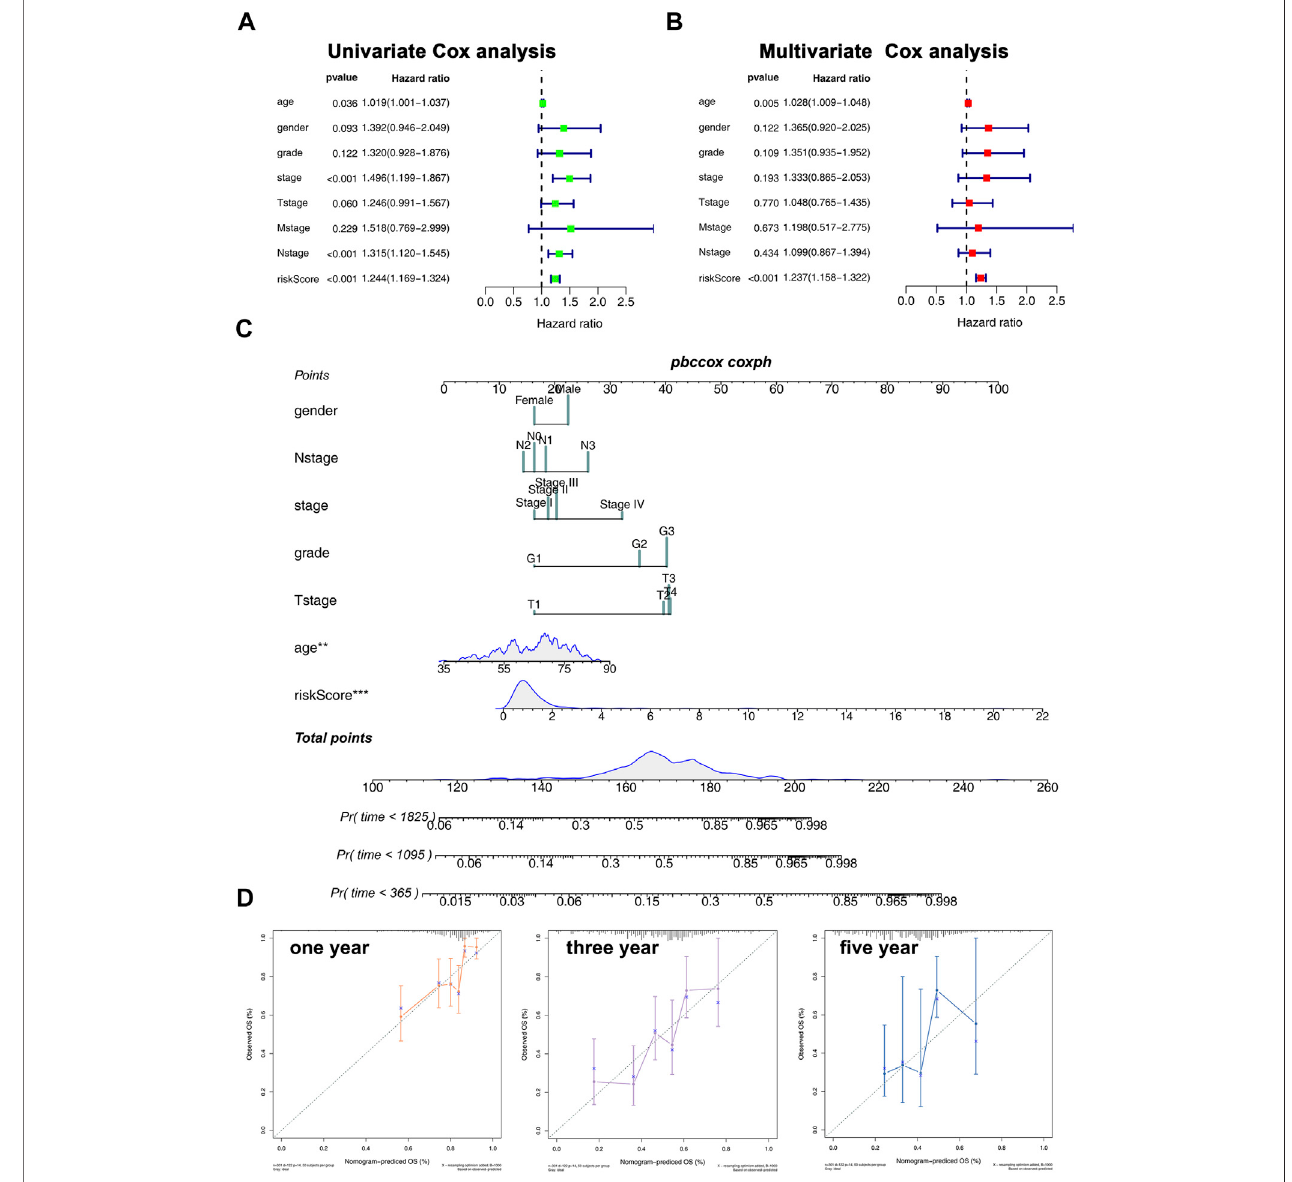
FIGURE 5 | Nomogram and calibration plots. (A,B) : Univariate (A) and multivariate (B) analyses were performed to explore whether the association between risk coreandpatientsprognosisisindependentofclinicalfeatures; (C) :Nomogramwasconstructedbasedontheriskscoreandclinicalfeatures; (D) :calibrationplotof1-,3- , and 5-year survival of nomogram predicted